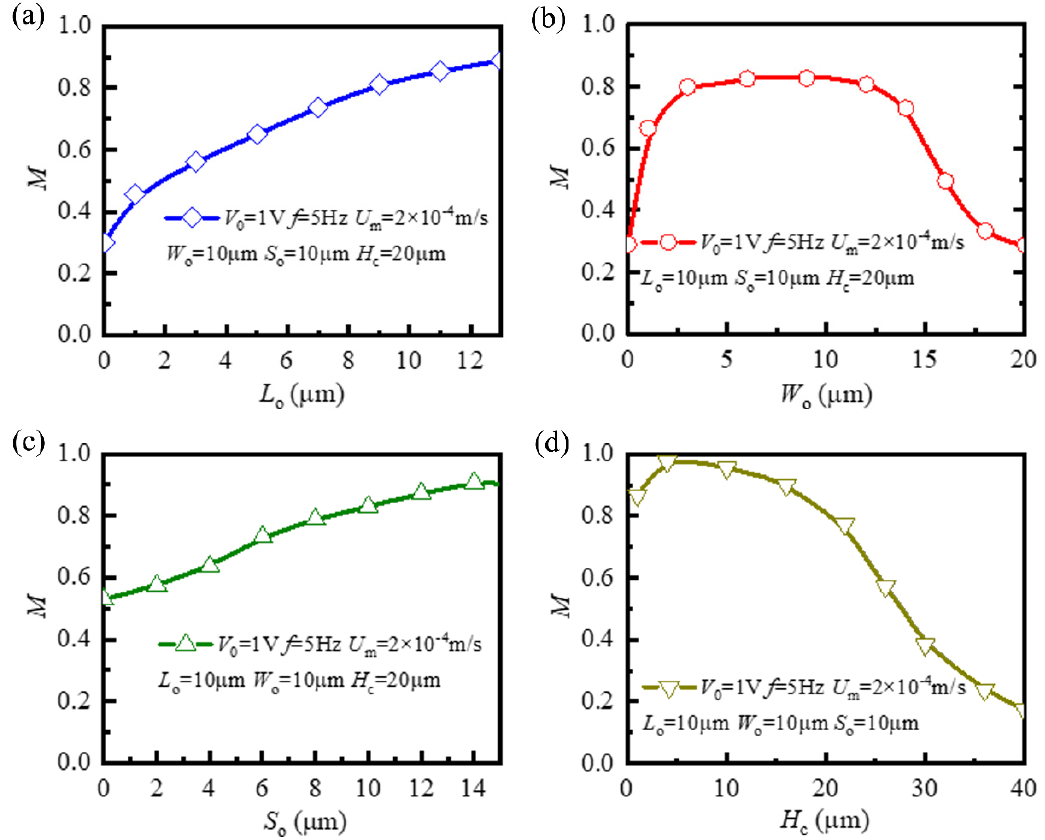
Figure 7. Mixing-efficiency index M near outlet depending on different geometric parameters. ( a ) Length L o , ( b ) width W o , ( c ) spacing S o of virtual electrode; ( d ) height H c of the microchannel.